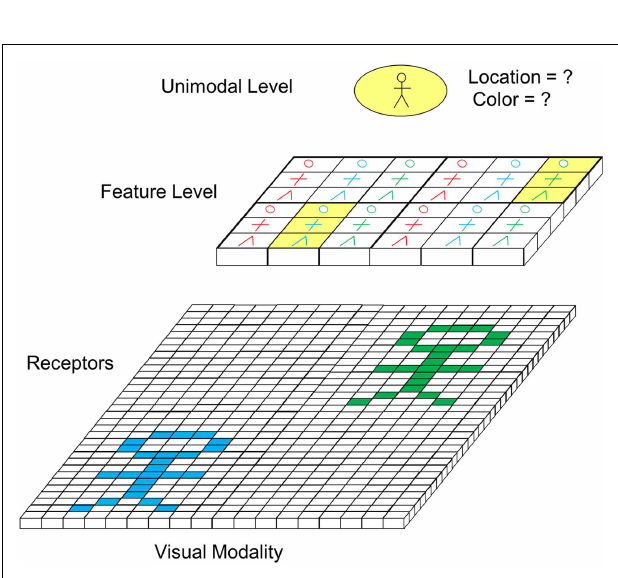
FIGURE 7 | Potentially ambiguous perception in case of presence of multiple objects (excitatory feedforward connections not depicted).